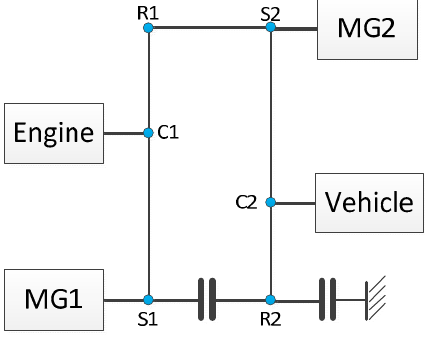
Figure 3. Lever diagram of the AHS.